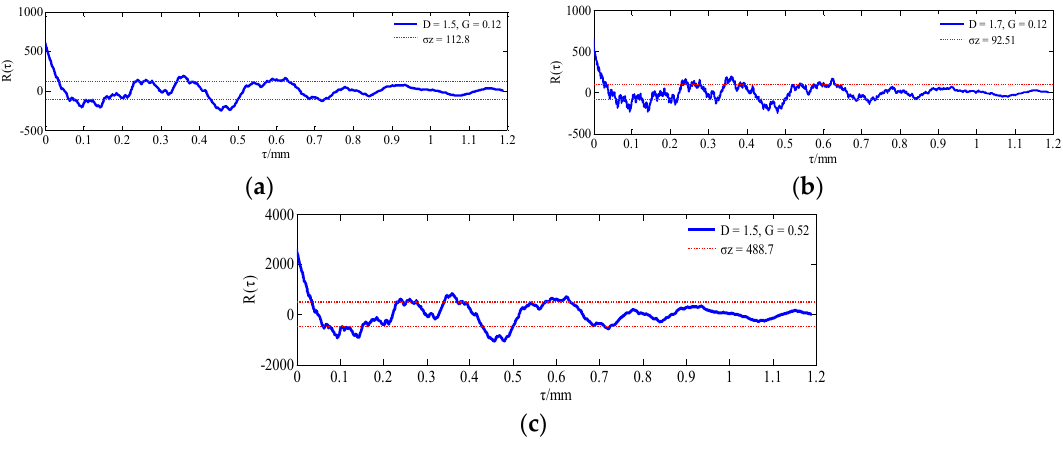
Figure 13. Autocorrelation graphs for different D and G : ( a ) D = 1.5, G = 0.12; ( b ) D = 1.7, G = 0.12; ( c ) D = 1.5, G = 0.52.